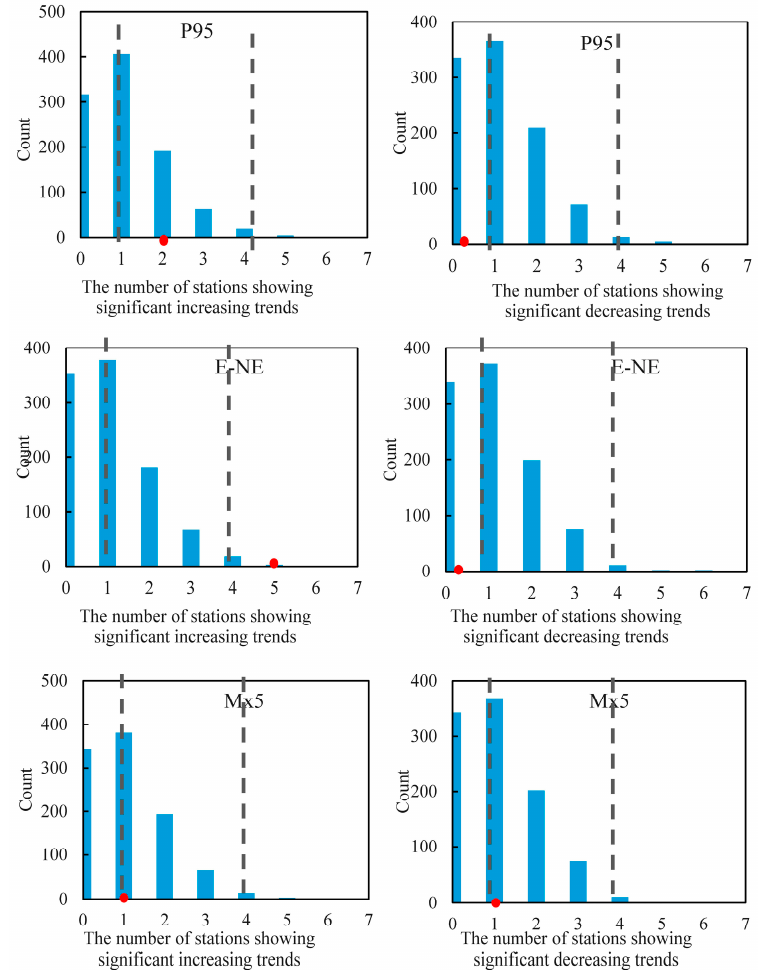
Figure 4. The field significant test for statistically significant increasing and decreasing trends. The bar chart represents the distribution of stations with a statistically significant trend after implementing the MK (Mann–Kendall) test on 1000 bootstrap extreme precipitation indices. The area between vertical black dashed lines represents 95% of the distribution. The red filled circle represents the number of stations with a statistically significant trend.